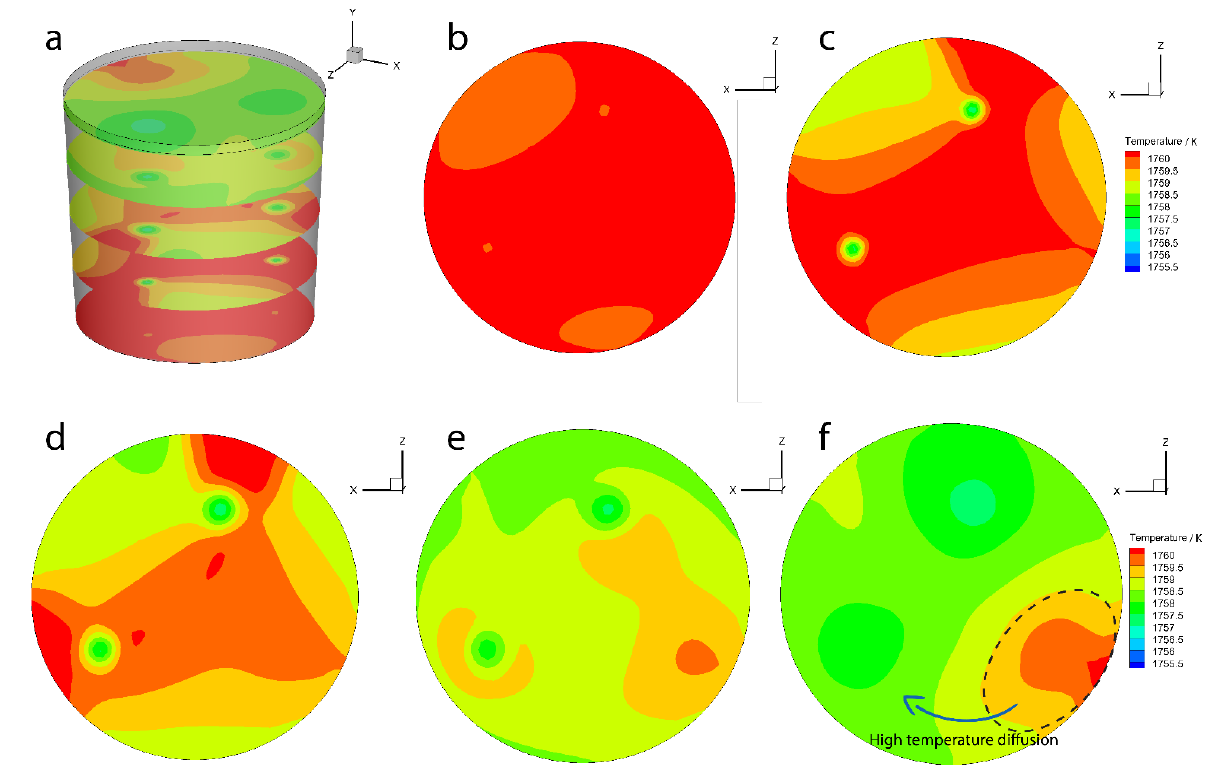
Figure 11. The temperature slice contour when the initial bubble temperature is 800 °C: ( a ) slice position, ( b ) slice position near the bottom, ( c ) slice position at Y = 0.3935, ( d ) slice position at Y = 0.787, ( e ) slice position at Y = 1.18, and ( f ) slice position at near the surface.